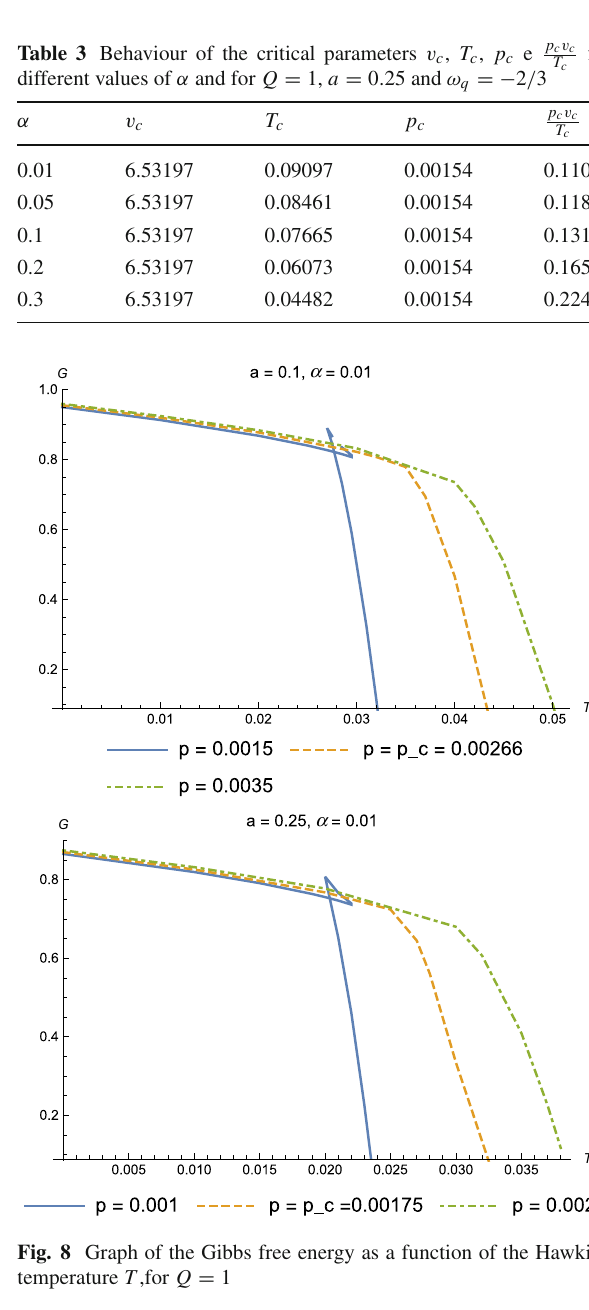
Fig. 8 Graph of the Gibbs free energy as a function of the Hawking temperature T ,for Q =